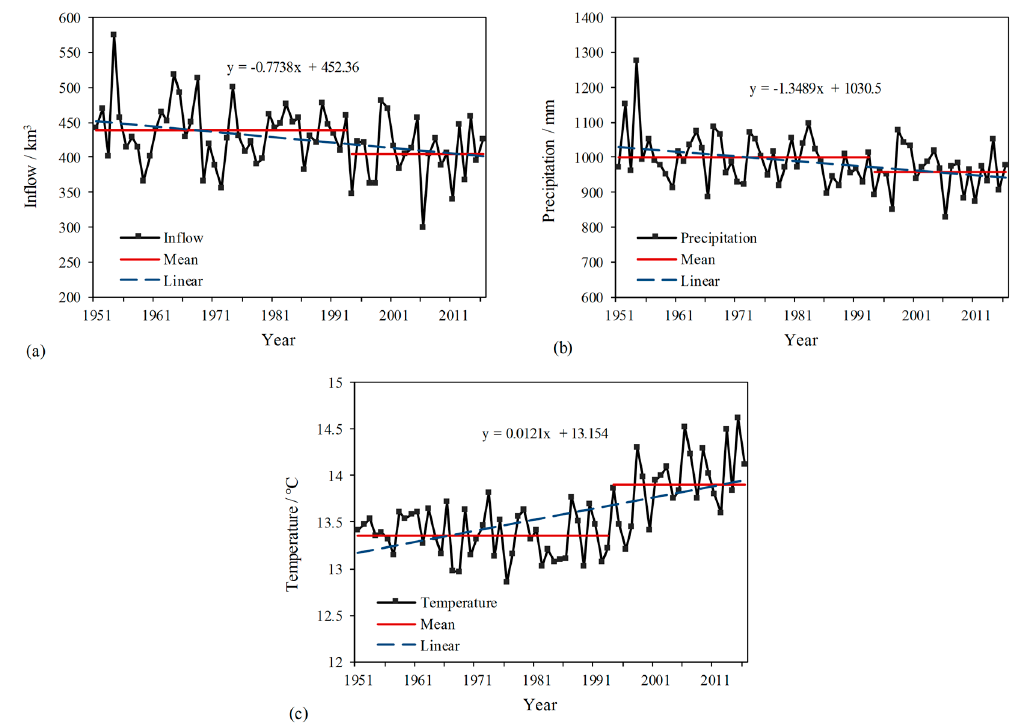
Figure 3. Long term variations of the Three Gorges reservoir annual inflow, annual total precipitation and annual average temperature: ( a ) annual inflow; ( b ) annual total precipitation; and ( c ) annual average temperature.